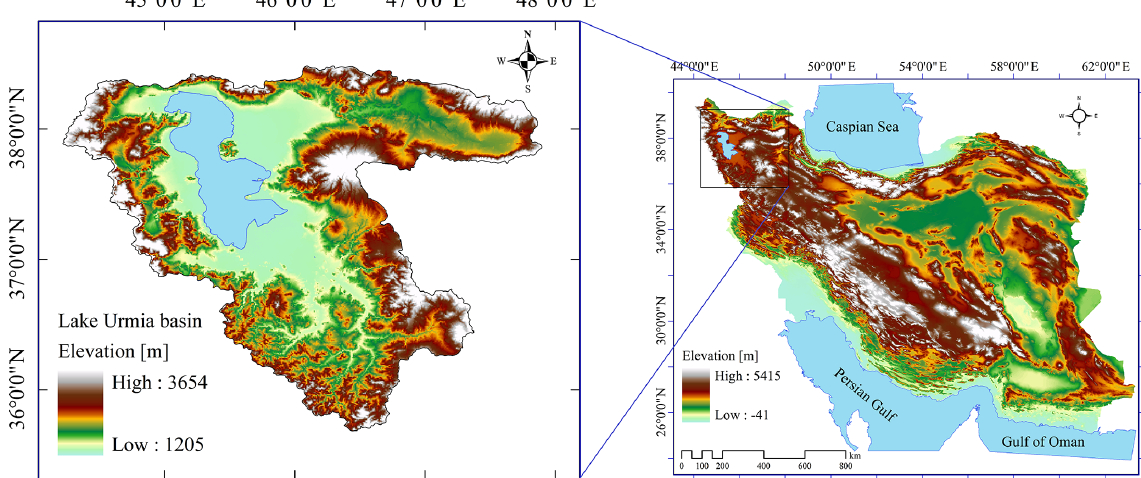
Figure 1. Location of Lake Urmia basin.